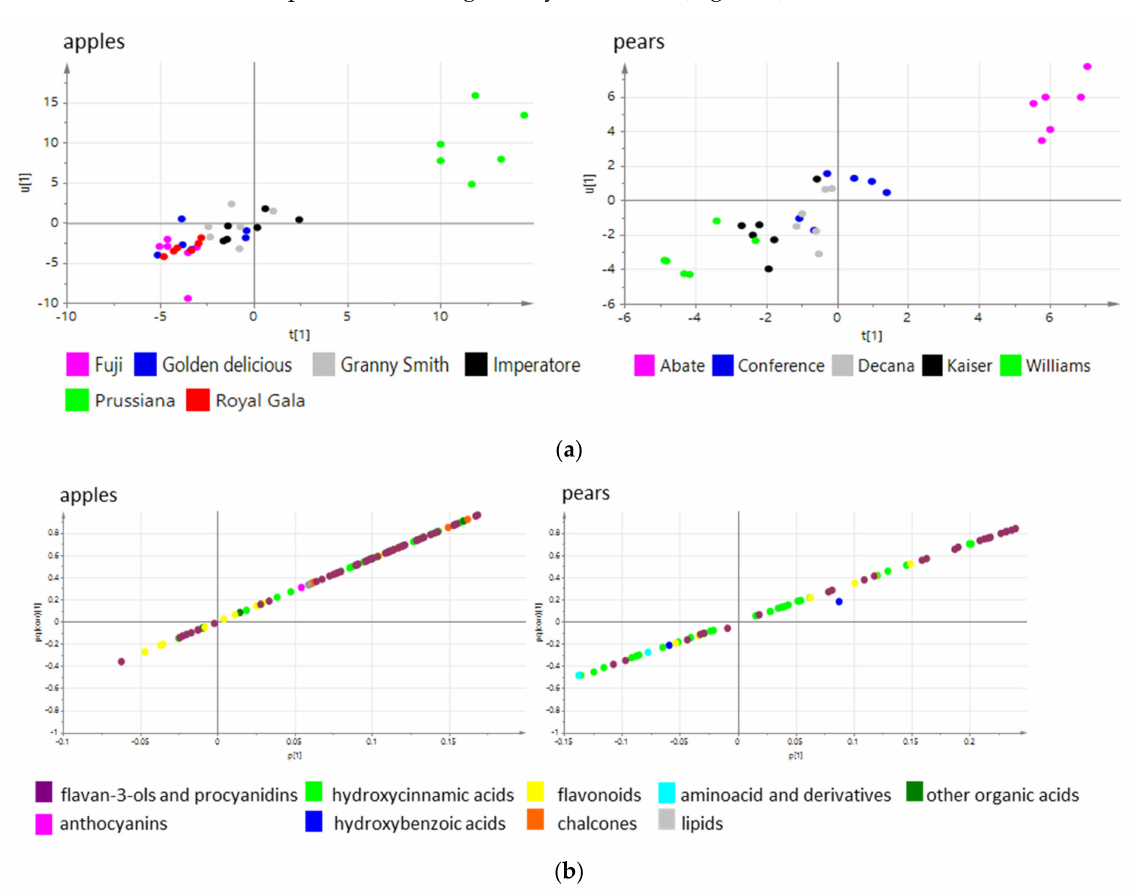
Figure 7. Supervised OPLS-DA of HPLC-ESI-MS data matrices for apple and pear cultivars to investigate the relation- ship between the antioxidant activity and the metabolomic profiles. ( a ) t1 versus u1 score plot; ( b ) p1 versus pq(corr)1 loading